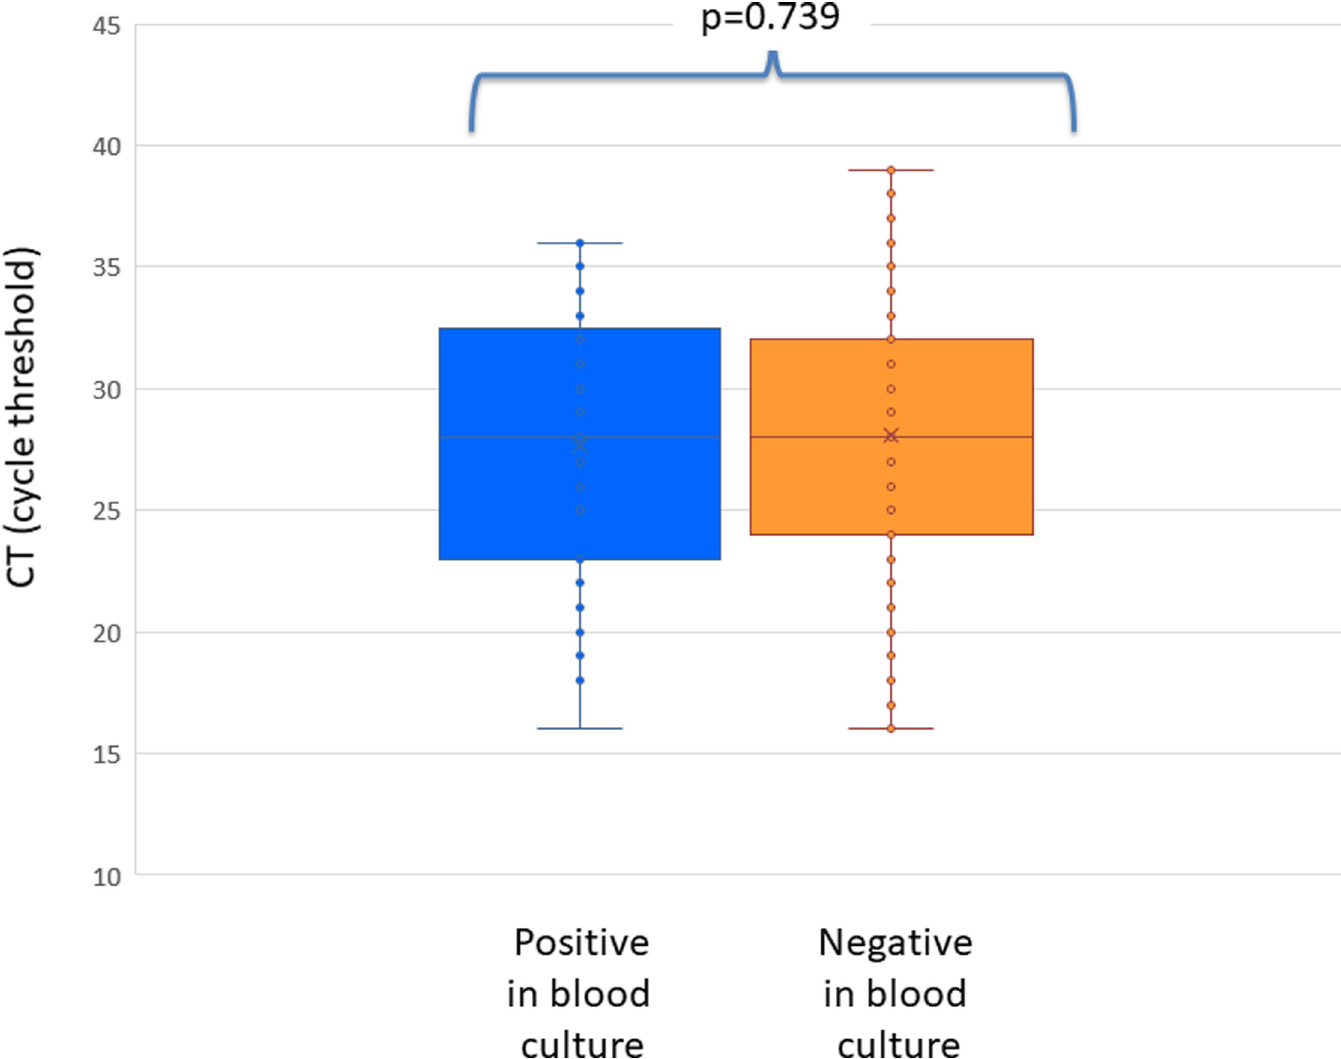
Fig 1. Cycle threshold in patients with invasive meningococcal disease who were found positive by qPCR in blood and who were positive (blue) or negative (orange) in blood culture. Cycle threshold is inversely proportional to bacterial load.